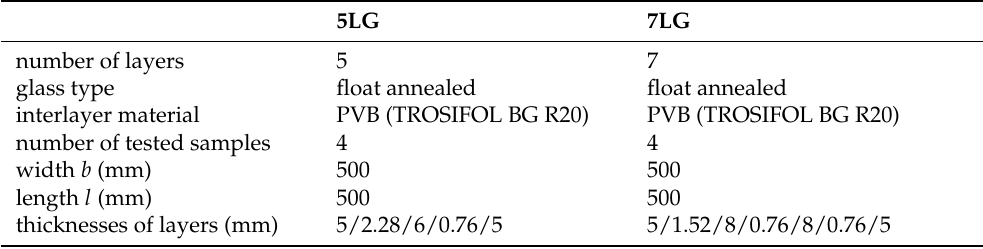
Figure 1. Example of a laminated glass. Table 1. Geometry of 5-layer (5LG) and 7-layer (7LG) laminated glass